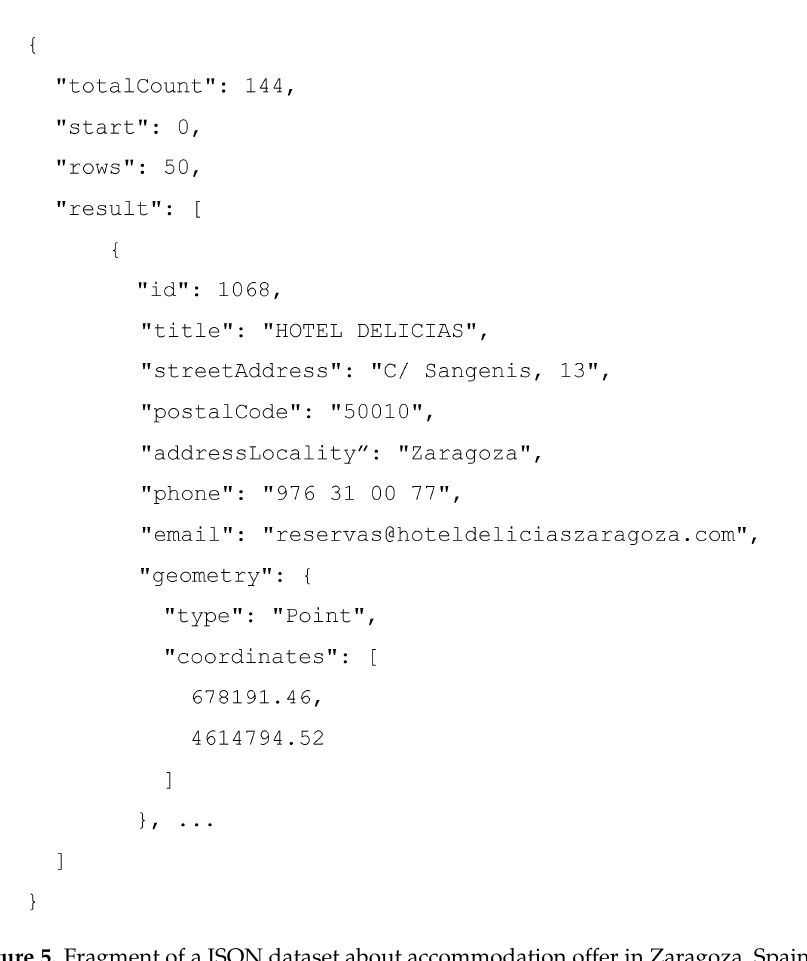
Figure 5. Fragment of a JSON dataset about accommodation offer in Zaragoza, Spain.